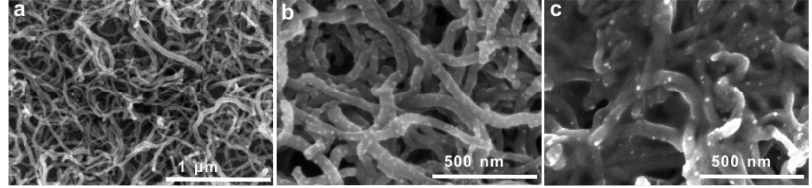
Figure 5. Scanning electron microscope images of ( a ) multi-walled carbon nanotubes (MWCNT), ( b ) Au nanoparticles-deposited MWCNT (Au/MWCNT); and ( c ) lectin-modified Au/MWCNT. Reprinted with permission from Zhang et al. [88].